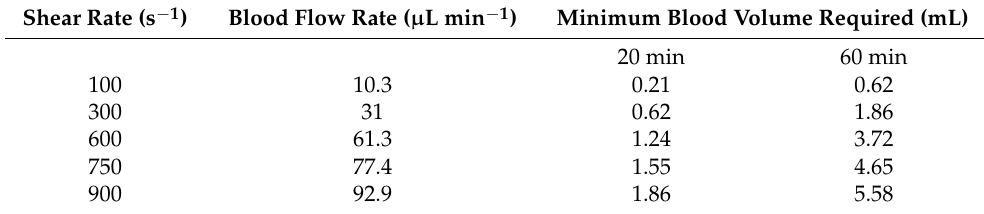
Table 1. Calculated volumetric flow rate and required blood volume at 100 s − 1 , 300 s − 1 , 600 s − 1 , 750 s − 1 , and 900 s − 1 shear rates 1